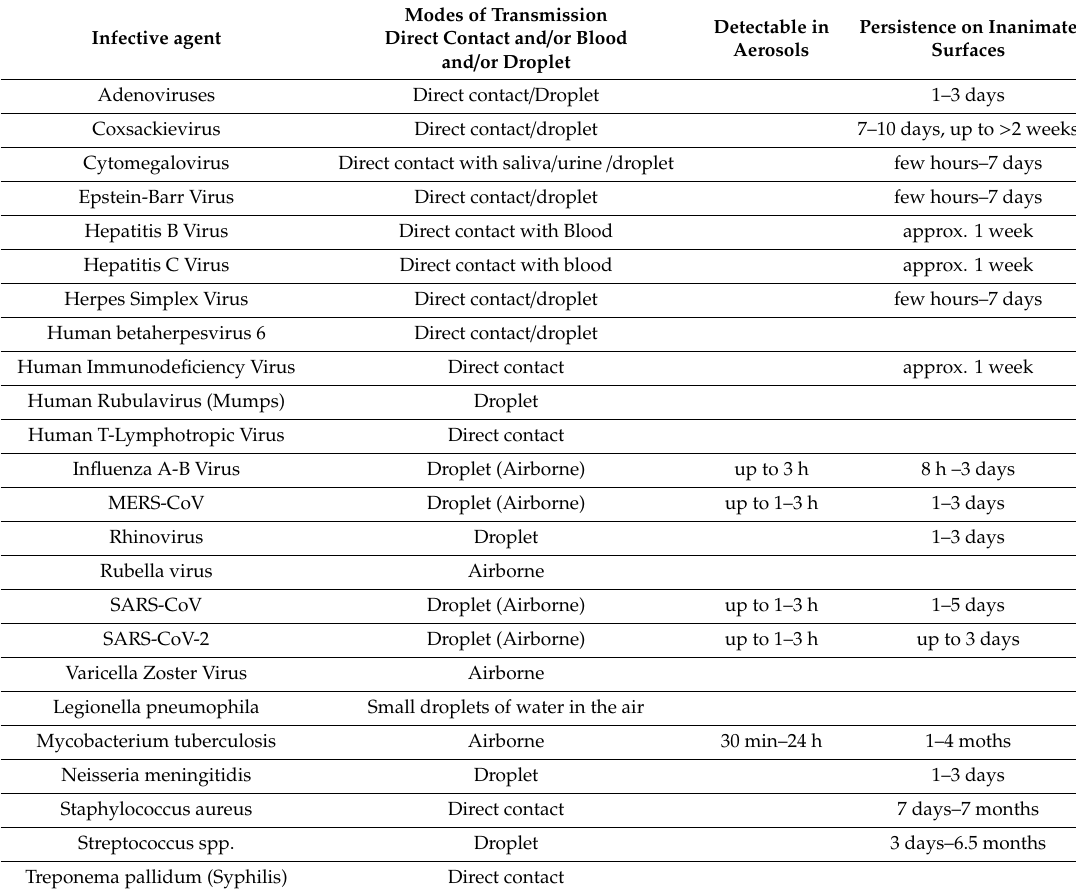
Table 1. Infectious agents and modes of